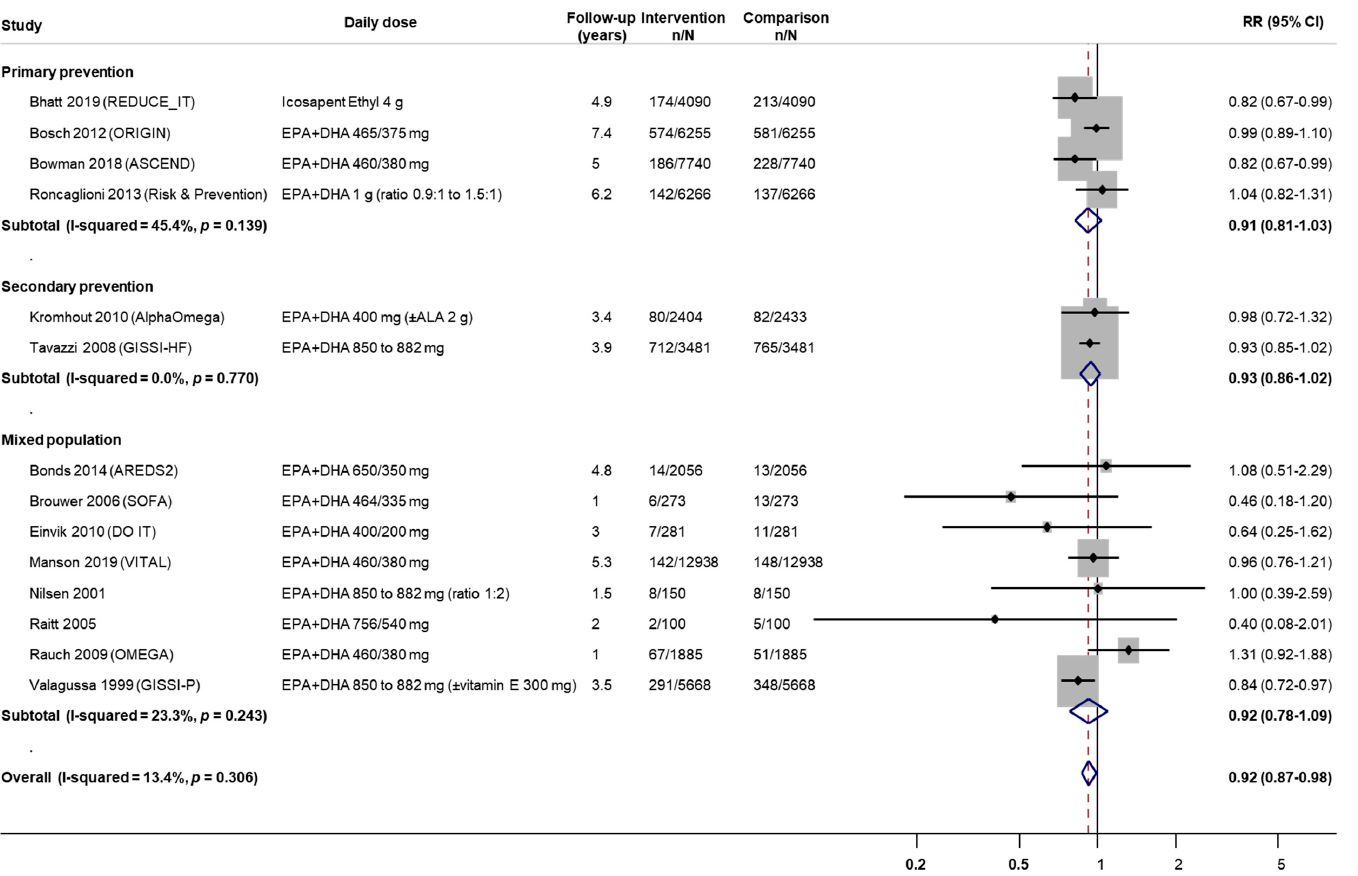
Figure A7. Subgroup meta-analysis for the effect of omega-3 supplementation on primary or secondary prevention of cardiovascular disease death. Full black quadrilateral represents the point estimate of individual studies and blank with quadrilateral represents pooled estimates. RR, relative risk; CI, confidence interval; EPA, eicosapentaenoic acid; DHA, docosahexaenoic acid. ALA, alpha-linolenic acid. Pooled estimates for the overall study population and subgroups are highlighted with bold